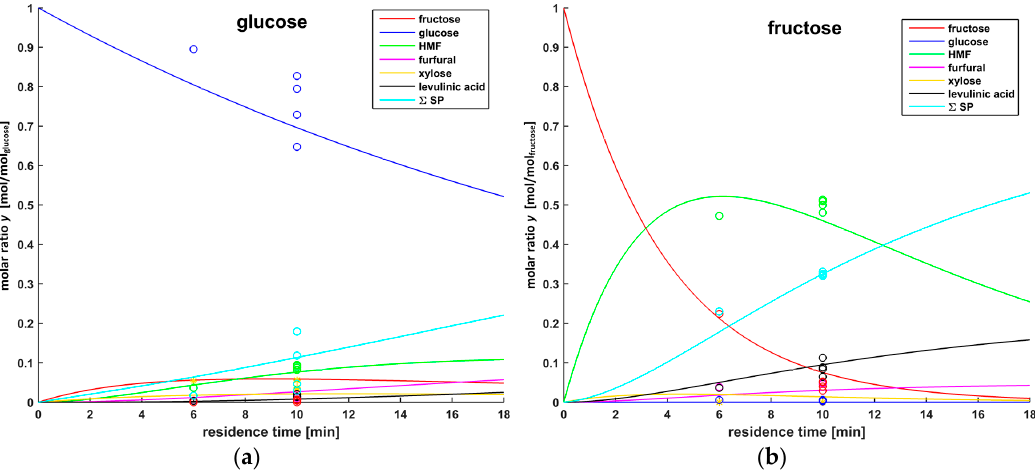
Figure 7. Kinetic plots of the acid-catalyzed conversion of ( a ) glucose and ( b ) fructose at 10 min residence time at 220 °C. The molar ratios measured y i,meas are shown as data points, and molar ratios calculated y i as lines. ∑ SP accounts for the sum of SP1, SP2, and SP3, as defined in Figure 2. Feedstock contained 0.005 mol/L sulfuric acid and either 1.05 wt % glucose or 1.05 wt % fructose. Table 1. First-order reactions according to the model (see Figure 2), with their rate coefficients k n at different reaction temperatures.